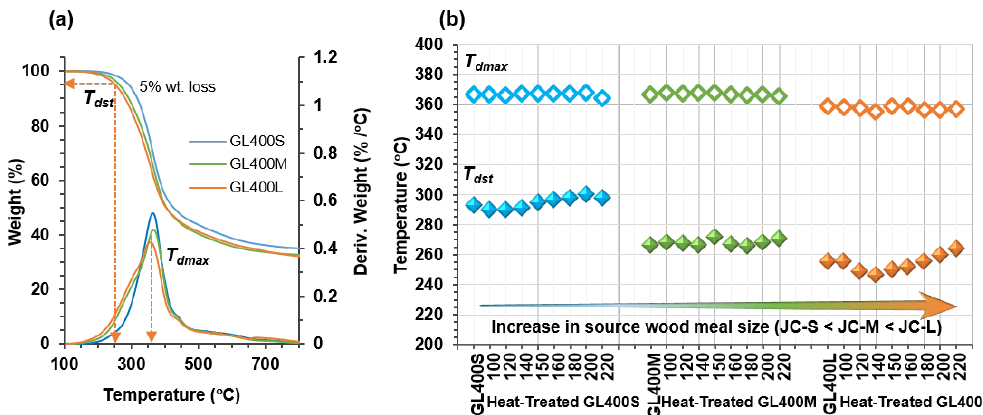
Figure 5. TGA / DTGA plots of control GL400S, GL400M, and GL400L ( a ) and thermal transition temperatures ( T dst and T dmax ) for the heat-treated GL400S, GL400M, and GL400L series, as determined by TGA ( b ). The samples were subjected to heat treatment at temperatures of 100–220 °C for 1 h. T dst : decomposition starting temperature corresponding to 5 wt% loss, T dmax : temperature corresponding to the maximum weight loss.